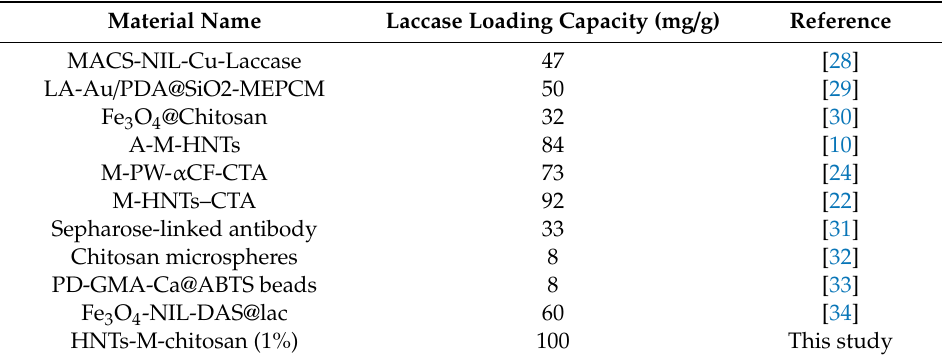
Table 1. The laccase loading capacity (mg / g) of recently reported